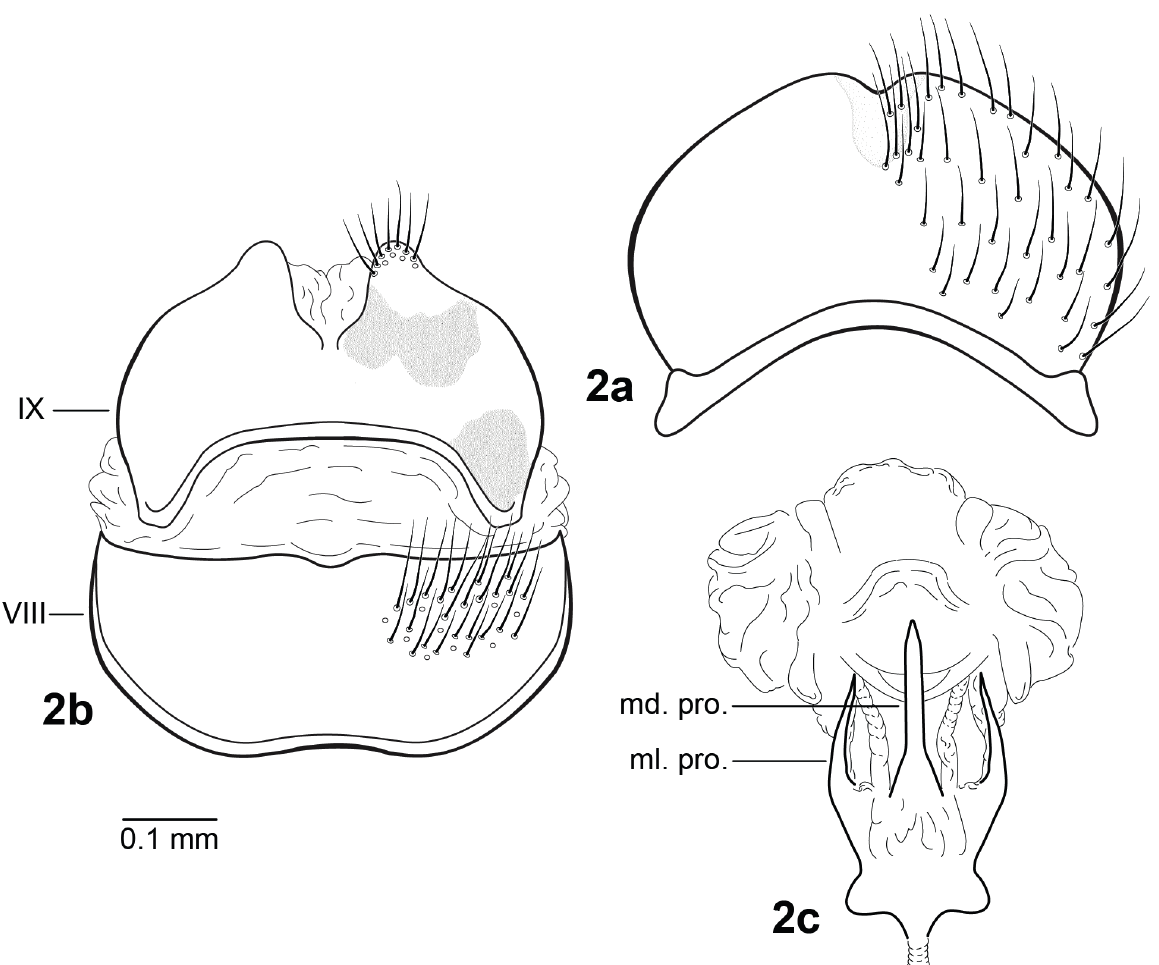
Figure 2 - Contulma vascaina sp. n., female genitalia. 2a . Sternum VIII, ventral; 2b . Apex of abdomen, dorsal; 2c . Vaginal apparatus, ventral. Abbreviations: VIII - tergum VIII; IX - tergum IX; md. pro. - medial process; ml. pro. - midlateral process. Scale: 0.1